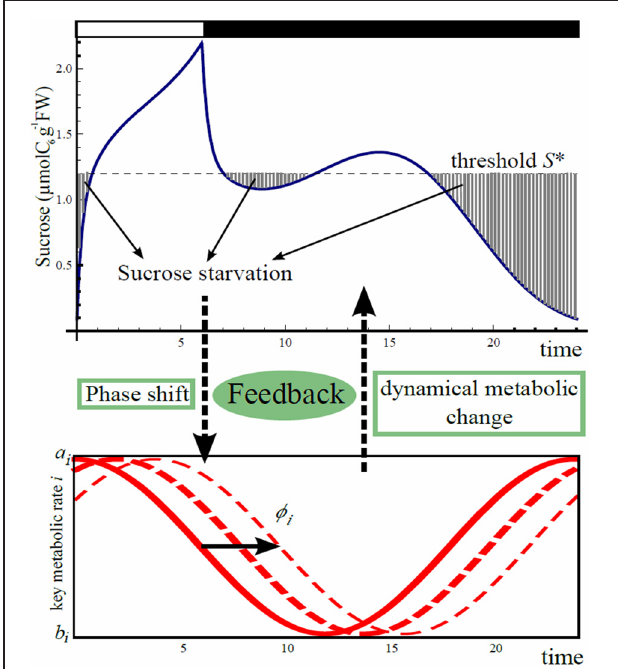
FIGURE 2 | Scheme of phase shift for starch metabolism and sucrose export driven by carbon starvation. Carbon starvation occurs when sucrose concentration goes below the threshold S ∗ . Starvation is integrated over 24h from dawn and will induce a shift in time in the oscillation of the three processes, carbon partitioning ( γ ( t ) ), starch degradation ( β ( t ) ), and sucrose export ( η ( t )